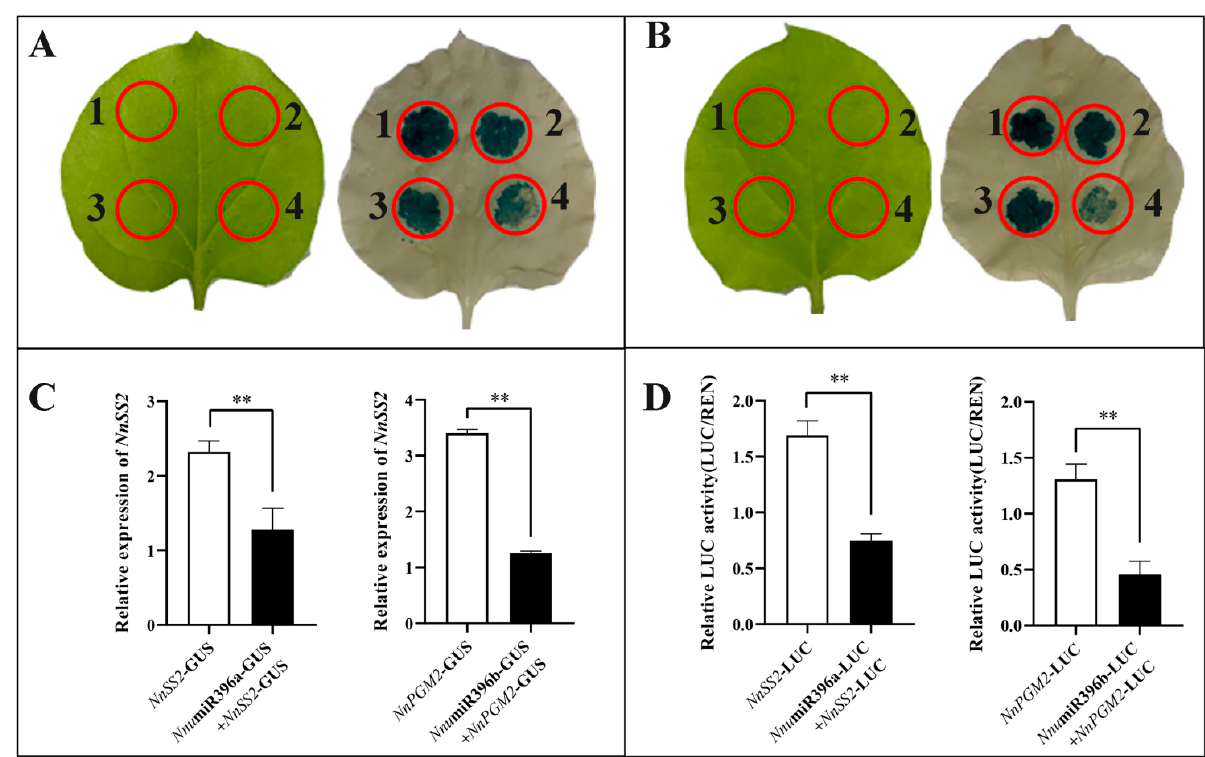
Figure 11. Transient co-expression experiment and dual luciferase assay of two key miRNAs and their target genes. ( A ) Transient co-expression experiment of Nnu miR396a and NnSS2 . 1: pbi121-GUS only, 2: NnSS2 -GUS only, 3: Nnu miRX-GUS + NnSS2 -GUS, 4: Nnu miR396a-GUS + NnSS2 -GUS. Nnu miRX represents one irrelevant miRNA. ( B ) Transient co-expression experiment of Nnu miR396b and NnPGM2 . 1: pbi121-GUS only, 2: NnPGM2 -GUS only, 3: Nnu miRX-GUS + NnPGM2 -GUS, 4: Nnu miR396b-GUS + NnPGM2 -GUS. Nnu miRX represents one irrelevant miRNA. ( C ) Relative expression level of NnSS2 and NnPGM2 in tobacco after injection. ( D ) Luc activity of NnSS2 and NnPGM2 in tobacco after injection. NtActin was used as the reference gene. All the data were calculated with three biological repeats. Error bars show SD from three biological replicates. The ‘**’ above the histogram indicated the statistical significance at the level of 0.01 ( p < 0.01).